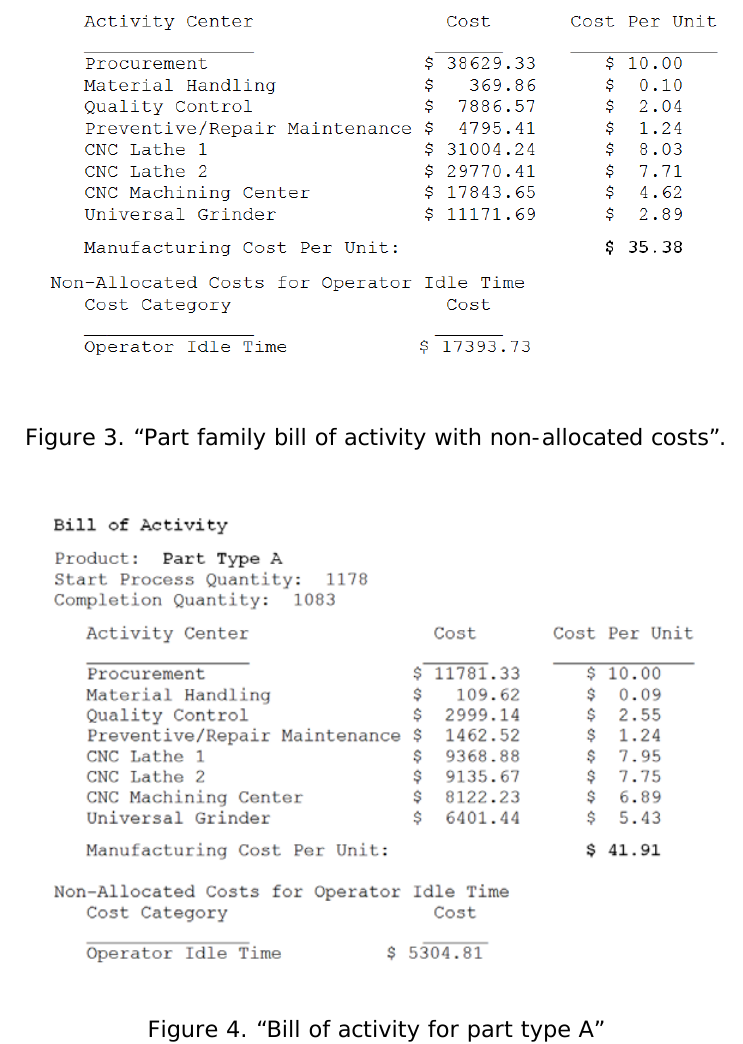
Figure 4. “Bill of activity for part type